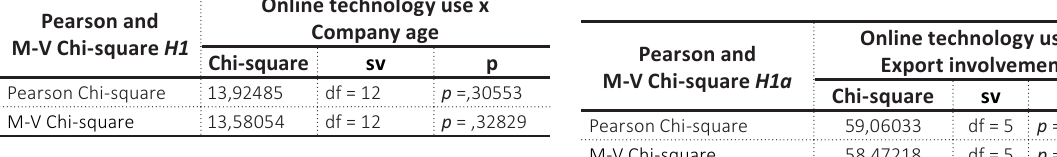
Table 2. Online technology use and Export